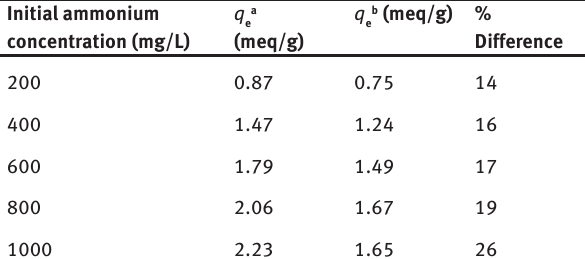
Table 6: Isotherms constants of the three isotherm models. Initial ammonium